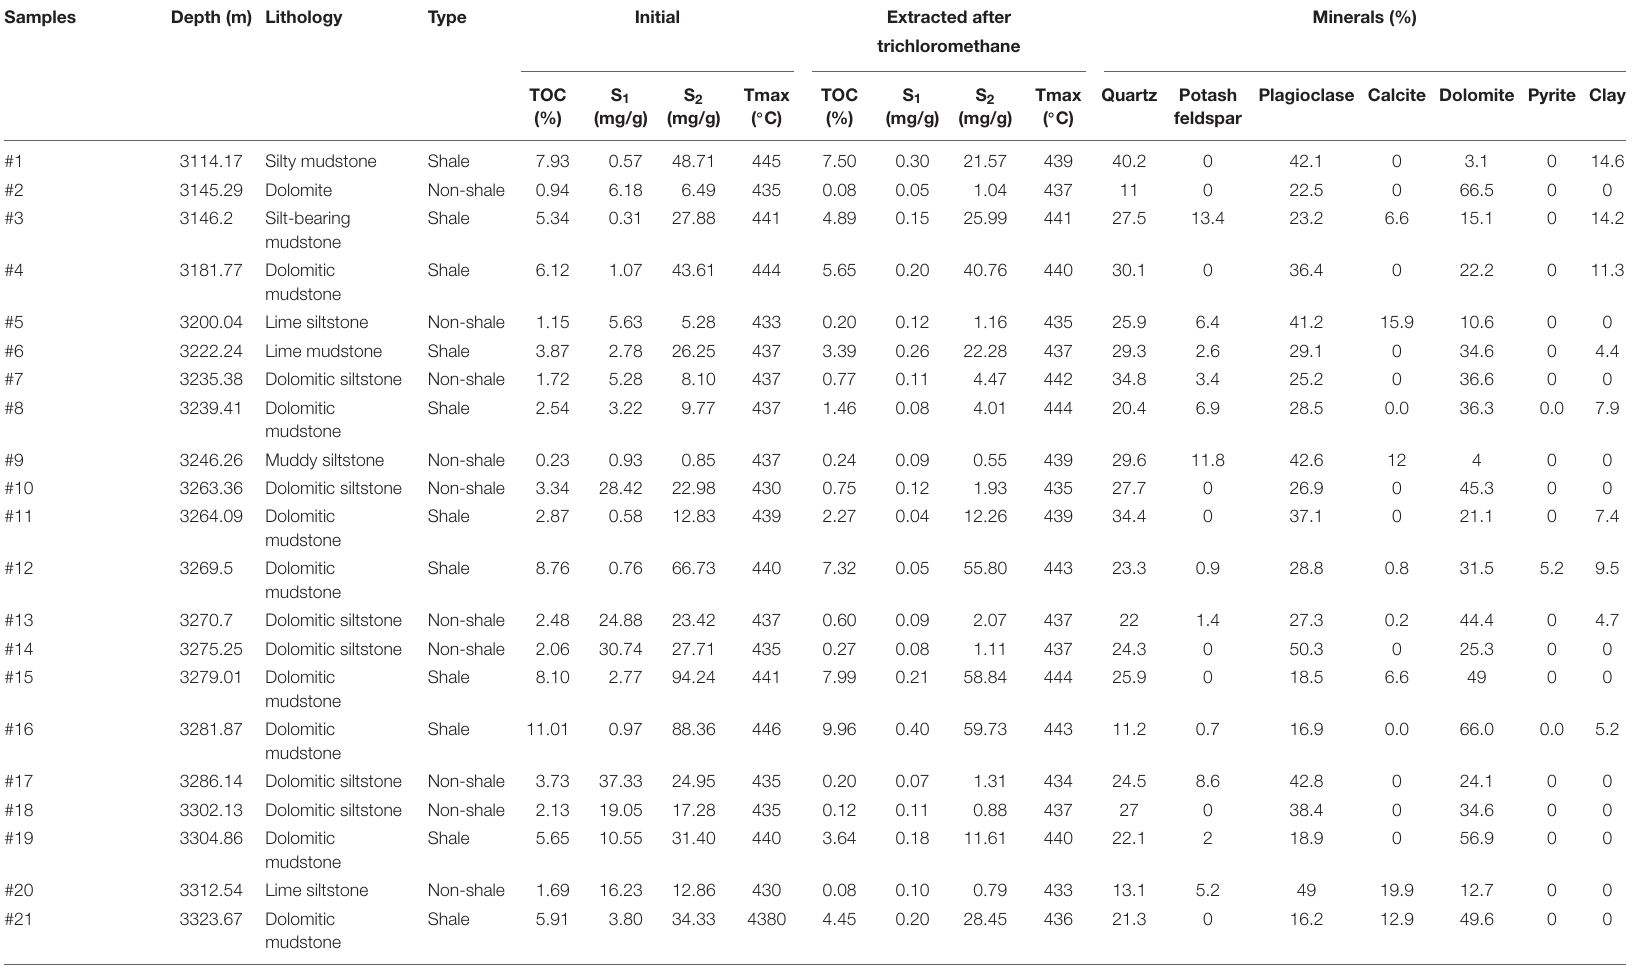
TABLE A1 | Basic geochemical information for the samples.